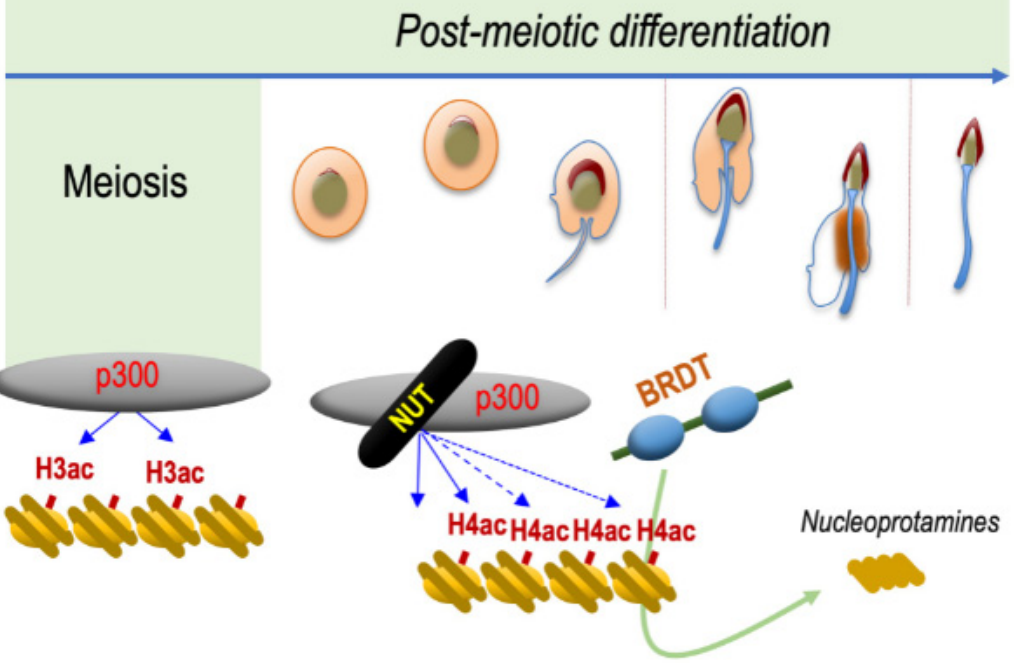
Figure 2. NUT is specifically expressed in post-meiotic spermatogenic cells and drives histone H4 hyperacetylation preceding histone eviction. The mechanism schematized is based on data published by Shiota and colleagues [4]. NUT, which is specifically expressed in spermatids, recruits CBP/p300, which are already expressed in all spermatogenic cell types. NUT stimulates their catalytic activity leading to the acetylation of H4 on both its lysines 5 and 8, which is required for the binding of the first bromodomain of BRDT. The binding of BRDT to H4K5acK8ac leads to the replacement of histones by protamines and the final compaction of the haploid male